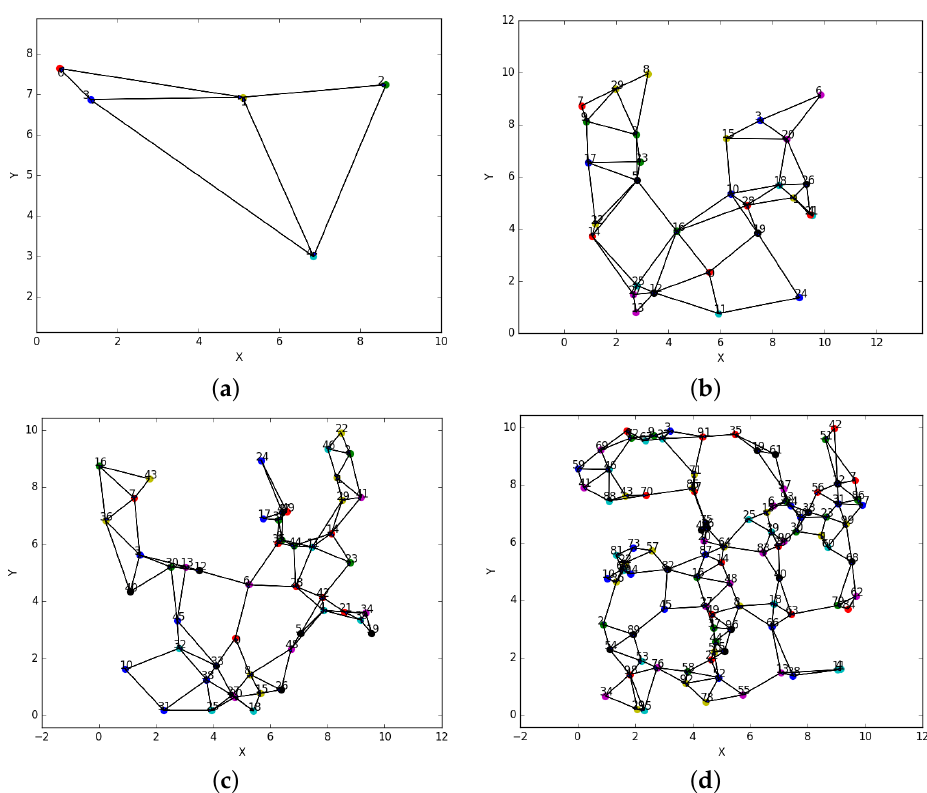
Figure 4. Generated minimally FOV persistent graphs using 5 { resp., 30,50, and 100 } robots when the sensing range R = 10 and the FOV α = π . ( a ) 5 robots, ( b ) 30 robots, ( c ) 50 robots, and ( d ) 100 robots.